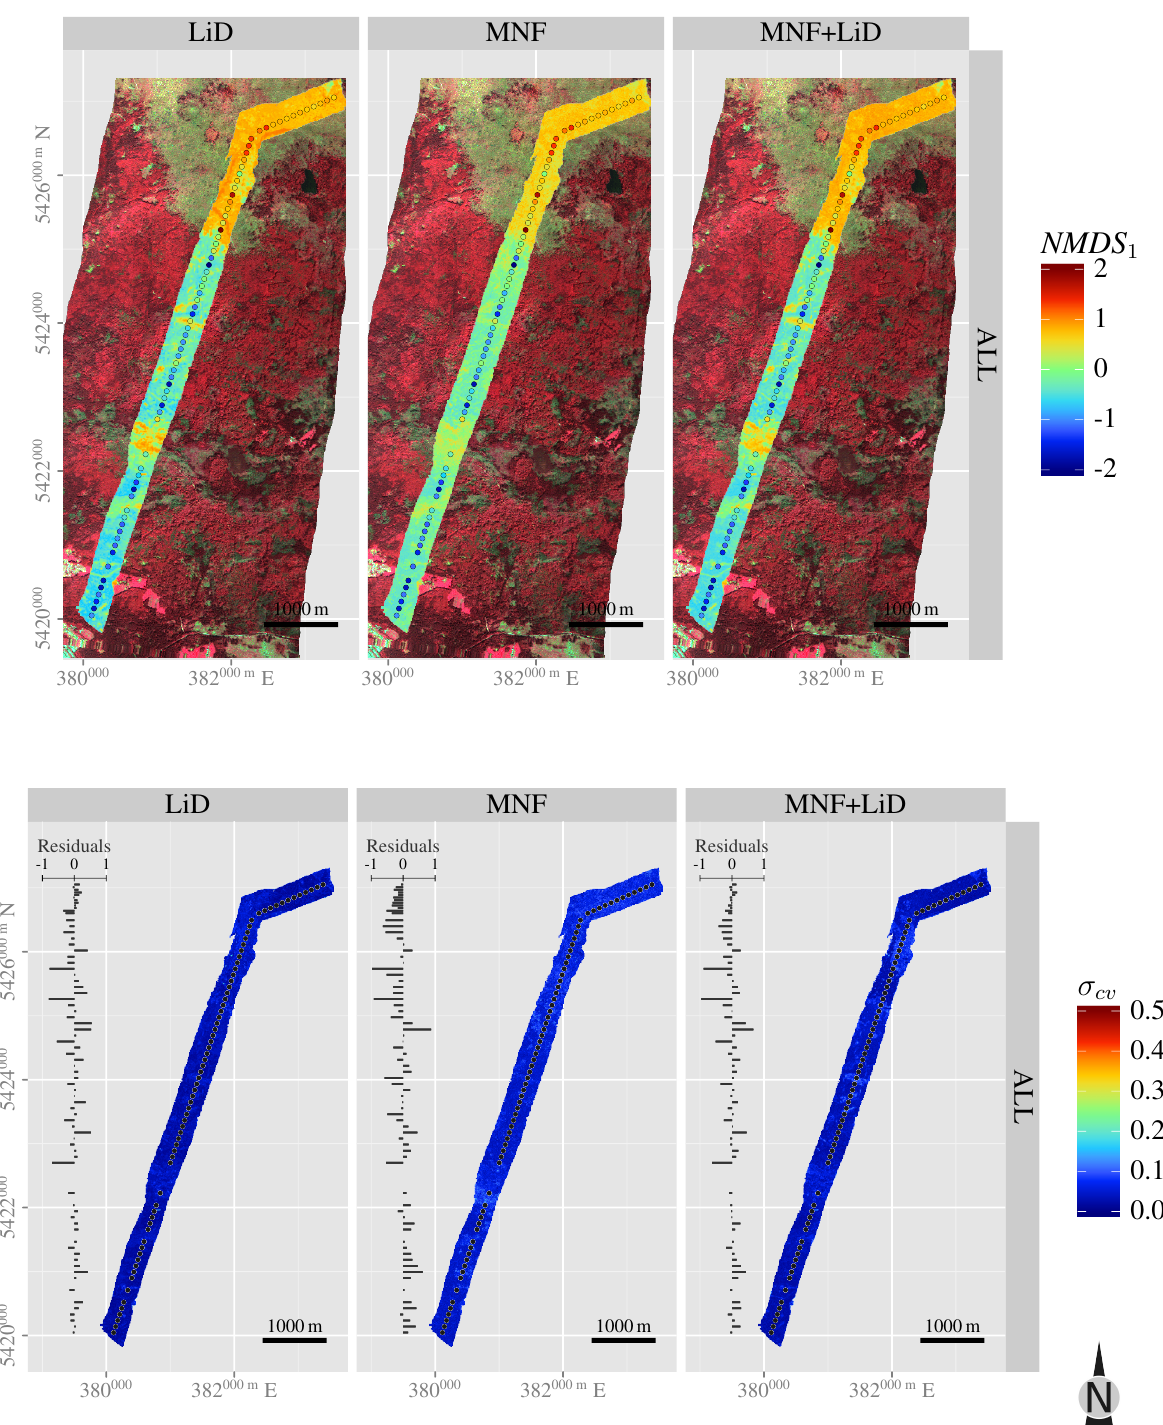
Figure 7. Spatial prediction of position on the first NMDS axis of all vegetation layers combined (ALL) for the LiDAR (LiD) and hyperspectral (MNF) predictor sets and their combination (MNF+LiD). Upper panel: averaged predictions of ten cross-validation models and plot information used to train and evaluate the random forests. Background: color-infrared composite of the HyMap data. Lower panel: standard deviation of the predictions of the ten cross-validation models. Bar charts show the residuals between predicted and observed estimates in cross-validation. Positive residuals are due to an overestimation by the model and vice versa .